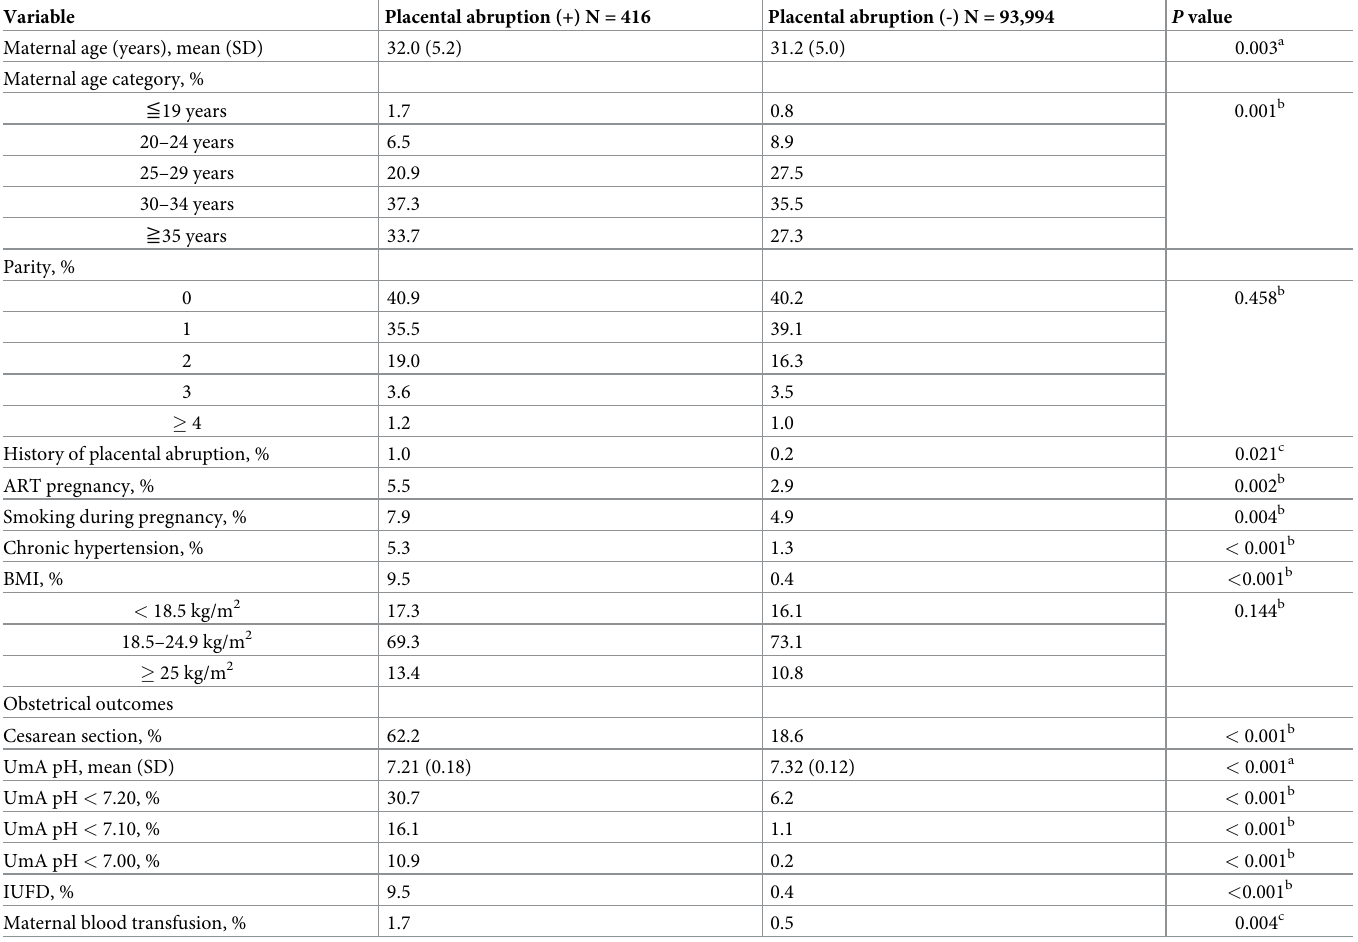
Table 1. Basic characteristics of the participants stratified by the presence and absence of placental